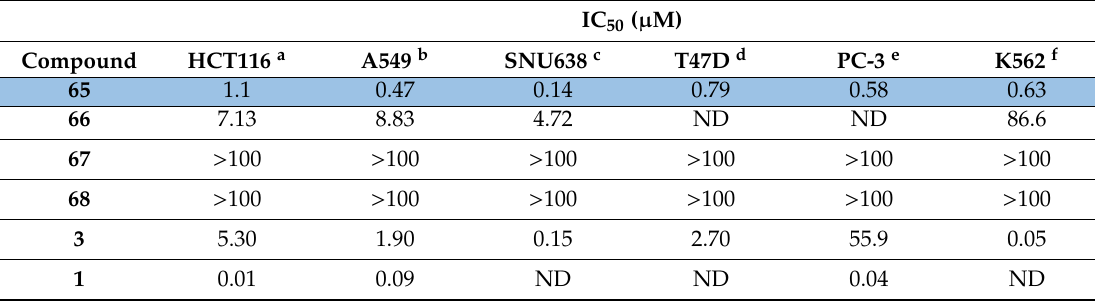
Table 2. Anticancer activity of 2’ - modified 4’ -selenoarabino nucleosides 65 – 69 compared to 1 and 3 across several human cancer cell lines.